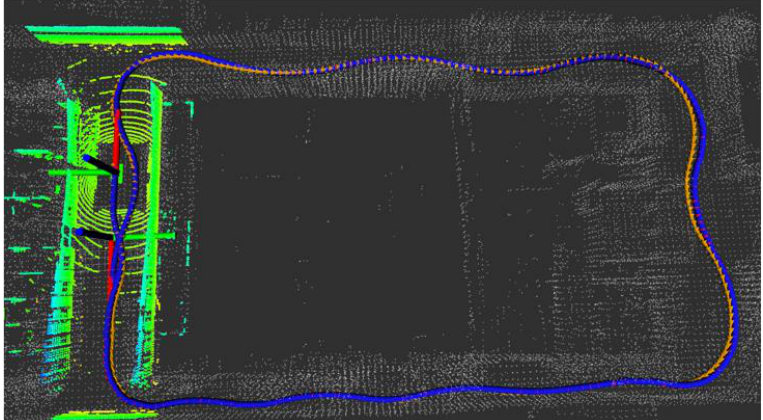
Figure 23. Field test NO.2. One lap under curve driving scenario localization test in prior point cloud map. The white points in the figure are the point cloud map built by the offline mapping process, the red line is the trajectory of LiDAR matching results, the orange line is groundtruth, and the blue line is the fused trajectory.